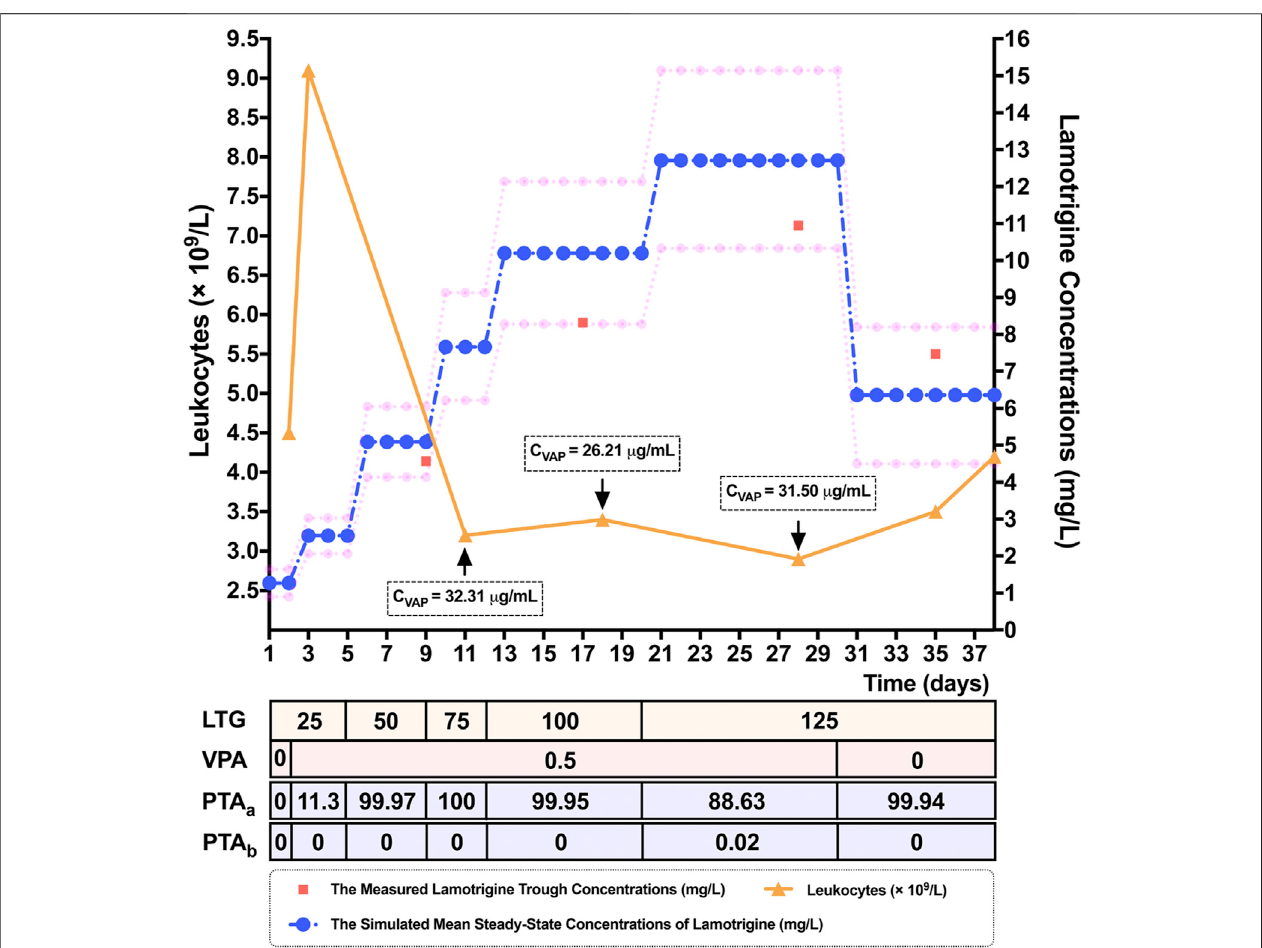
FIGURE 3 | Simulated mean steady-state concentrations ( C ss ) (represented by blue dots) and the corresponding 10th and 90th percentiles (represented by pink dots), of the response to lamotrigine (LTG) for dosing regimens of 25 mg/bid to 125 mg/bid by adolescent Chinese patients with epilepsy weighing 60 kg in a 10,000- virtual patient Monte Carlo (MC) simulation. The 80% prediction interval, encompassing 80% of the simulated sample, adequately captured the measured LTG concentrations (represented by red squares) of a 15-year-old female epileptic Chinese patient weighing 60 kg. The patient ’ s leukocytes (represented by orange triangles) decreased when the LTG concentration was increased, and had normalized when she was discharged. Note. LTG: the dosing titration regimens of LTG (mg/ bid), VPA: the dosing titration regimens of the co-administered valproate acid (VPA) (g/qd), C VPA : the measured trough concentrations of VPA, PTA a : the probability of target attainment values (%) needed to reach C ss within the range of 3 – 15 mg/L, PTA b : the probability of target attainment values (%) needed to reach C ss ≥ 20 mg/L.